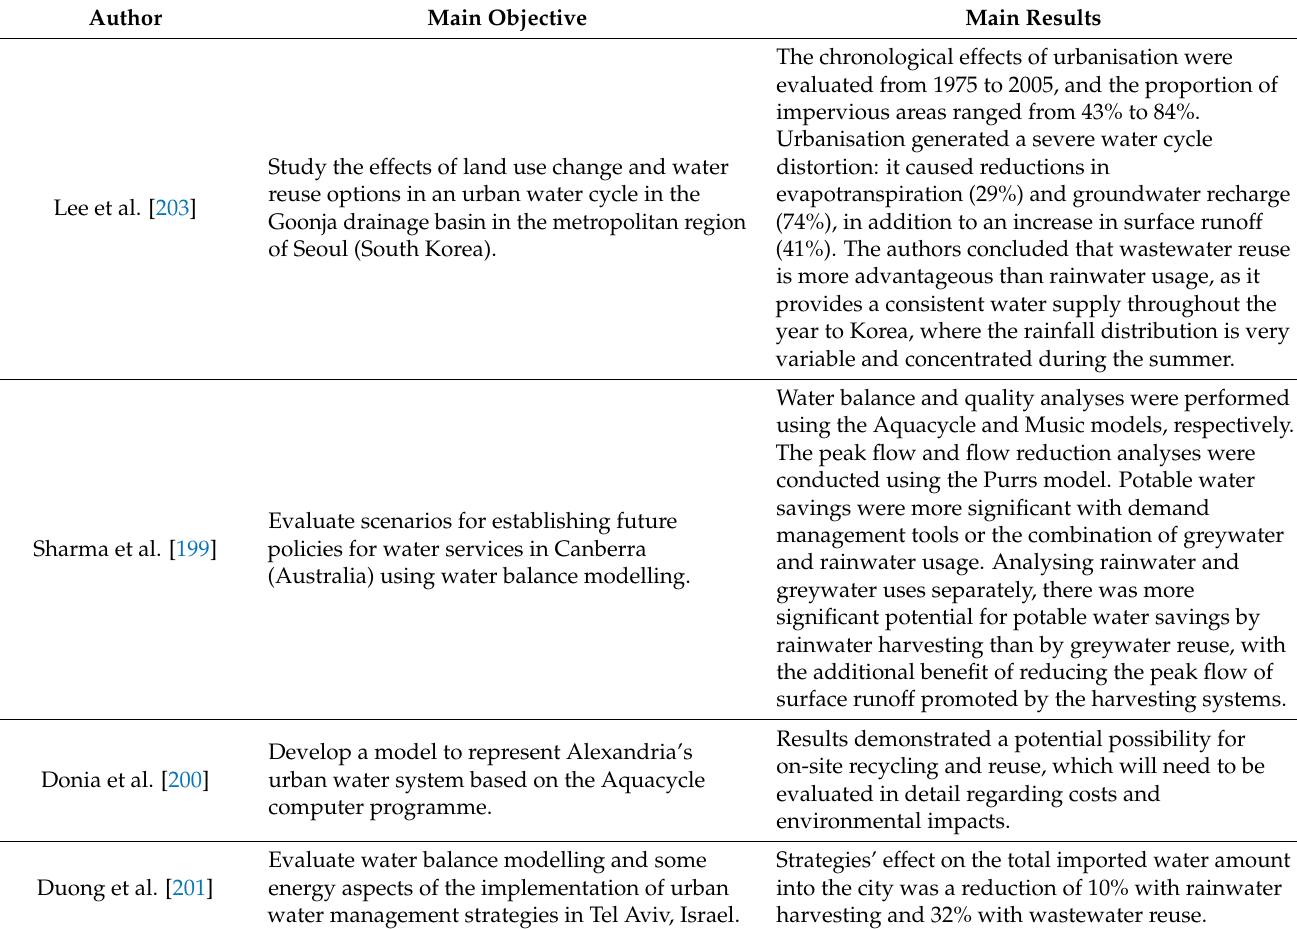
Table 8. Research studies about water balance modelling using